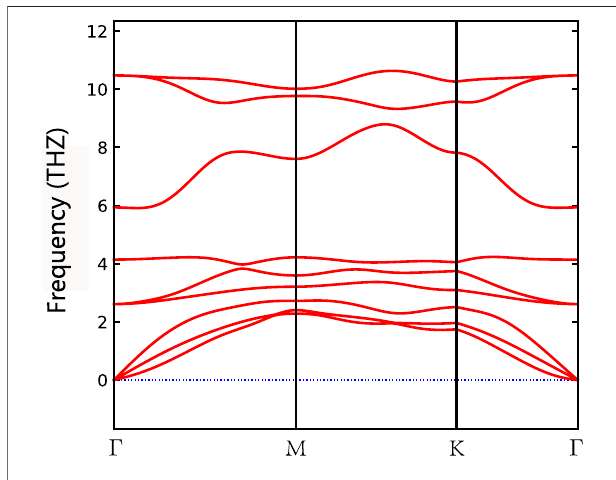
FIGURE 2 | Phonon spectrum of Nd 2 N structure.